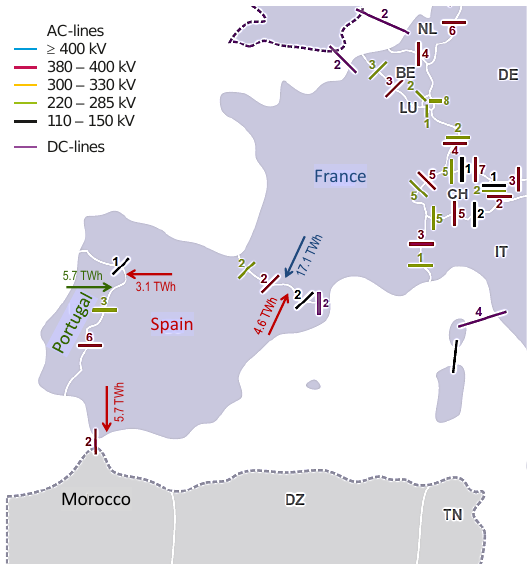
Figure 1. Cross-border interconnection of the Spanish continental electricity system with its neighbouring countries. Number of circuits and rated voltages on cross-frontier transmission lines and annual energy exchanges in 2017.